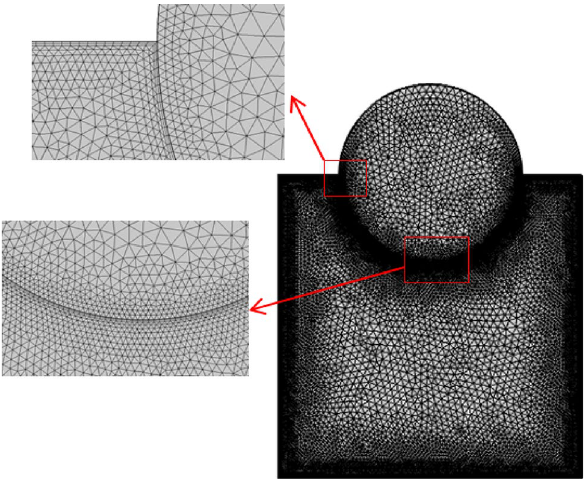
Figure 2. Mesh distribution of the physical